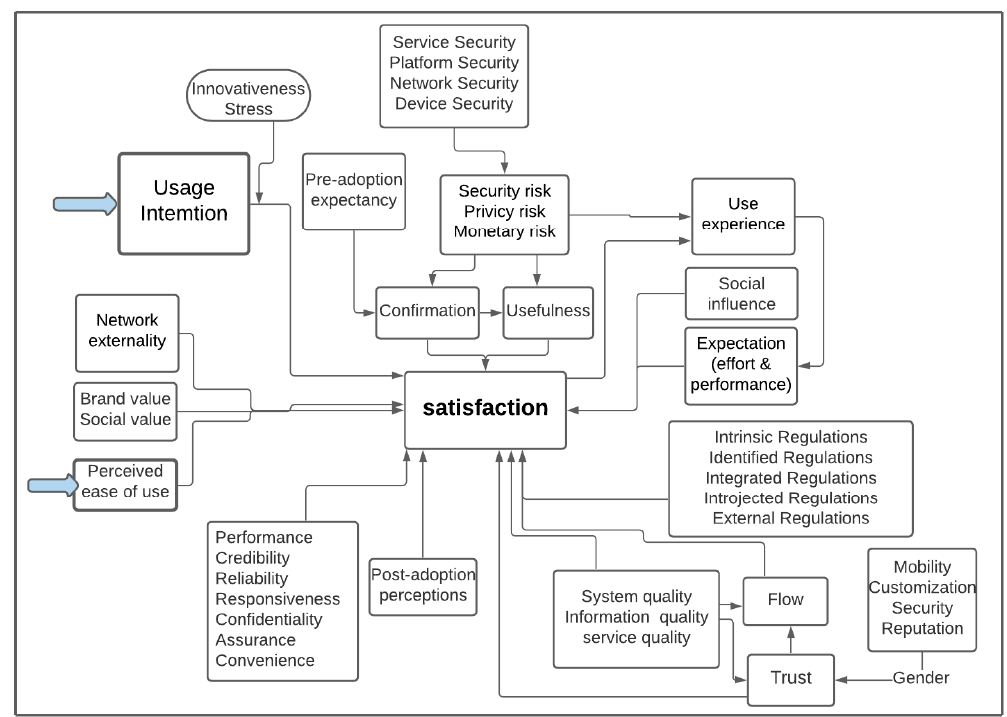
Figure 6. The satisfaction factors model of electronic payment.